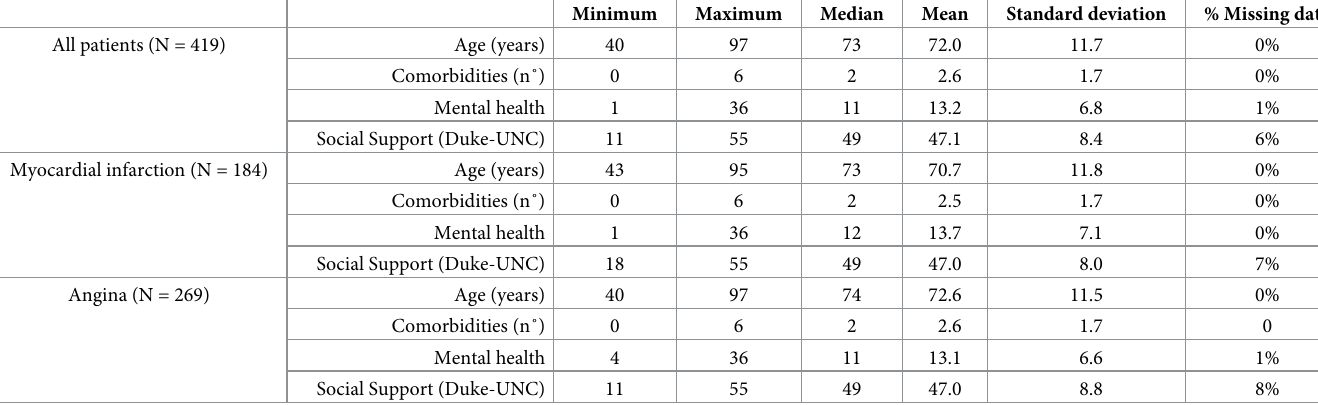
Table 2. Descriptive statistics (minimum, maximum, mean and standard deviation) for the continuous variables used in the study (N = 419).